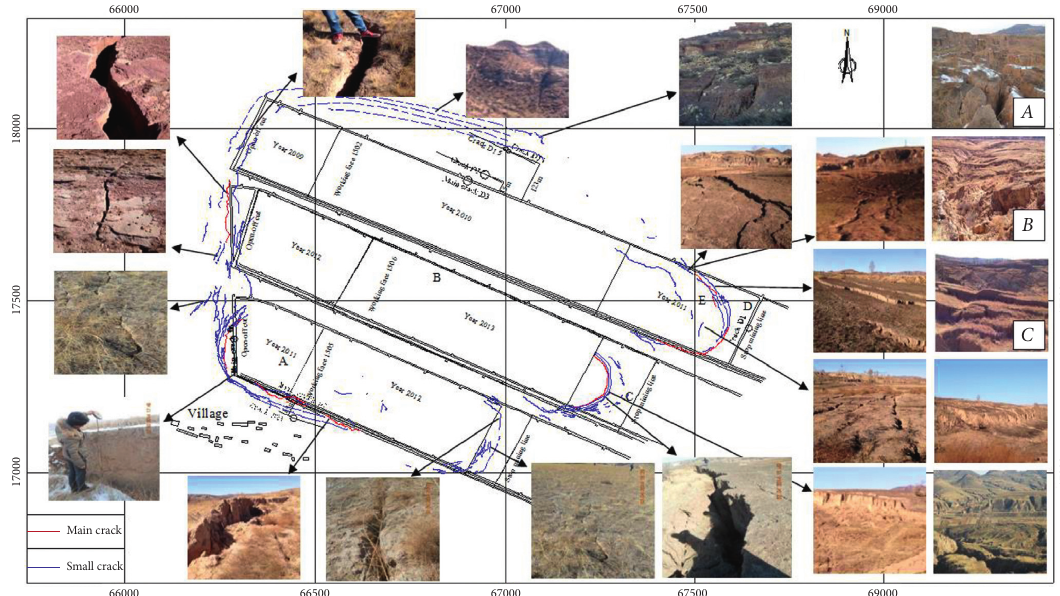
Figure 3: Distribution of surface cracks and cracks relative position and cracks